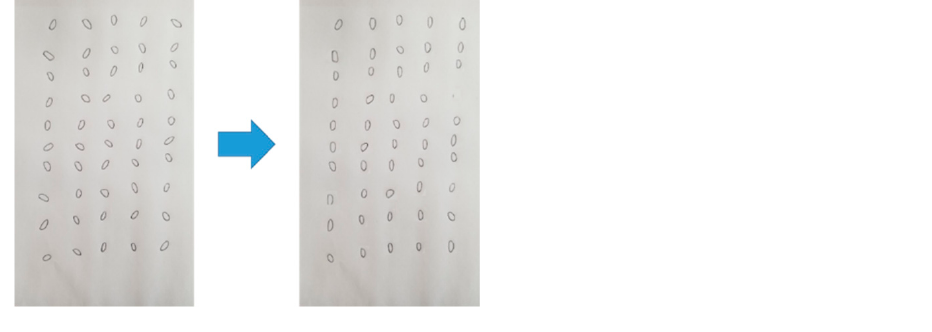
Figure 13. Tilt correction examples of “0” following the proposal ( left : original, right : tilt correction results).